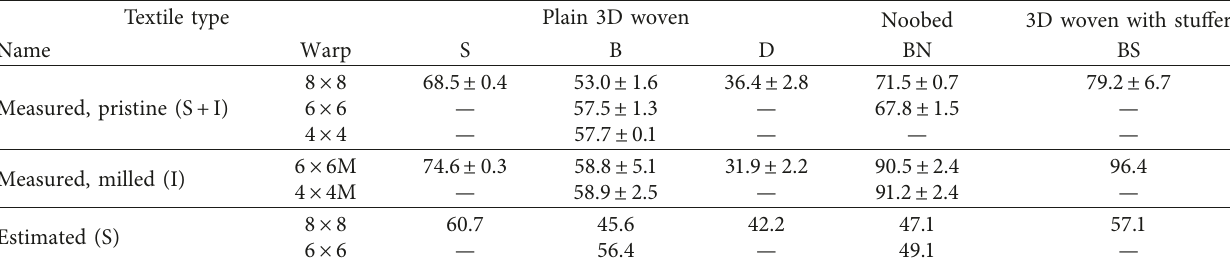
Measured, milled (I)